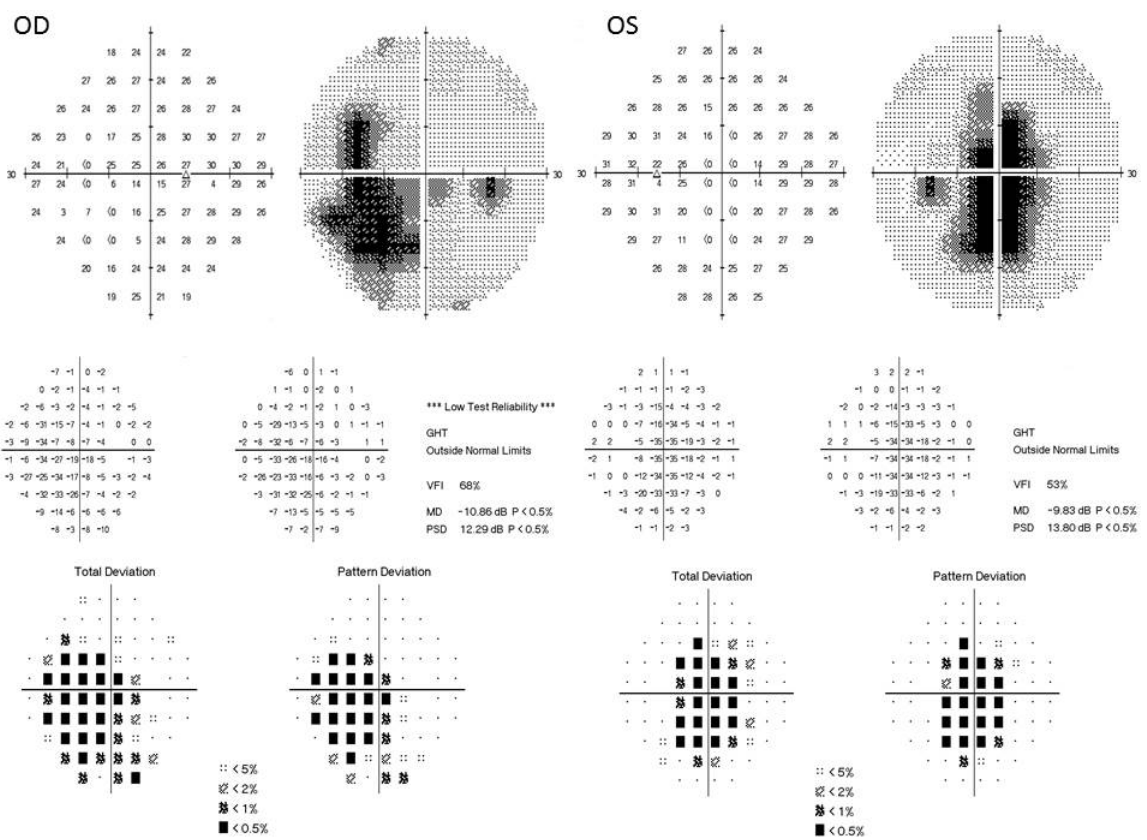
Figure 2: Central and paracentral field defects in both eyes in 30-2 Humphery visual fields (HVF)